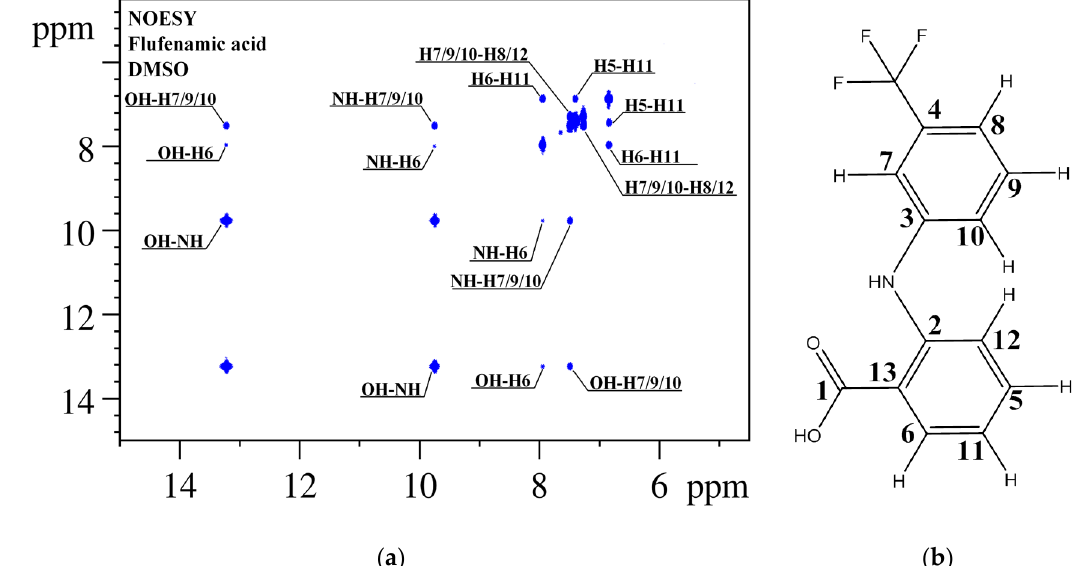
Figure 5. 1 H- 1 H NOESY NMR spectrum ( a ) of FFA ( b ) in DMSO-d 6 . The observed cross-peaks correspond to the groups of 1 H- 1 H atoms located at a distance of up to 5 Å from each other and are numbered according to the structure shown in Figure 2.